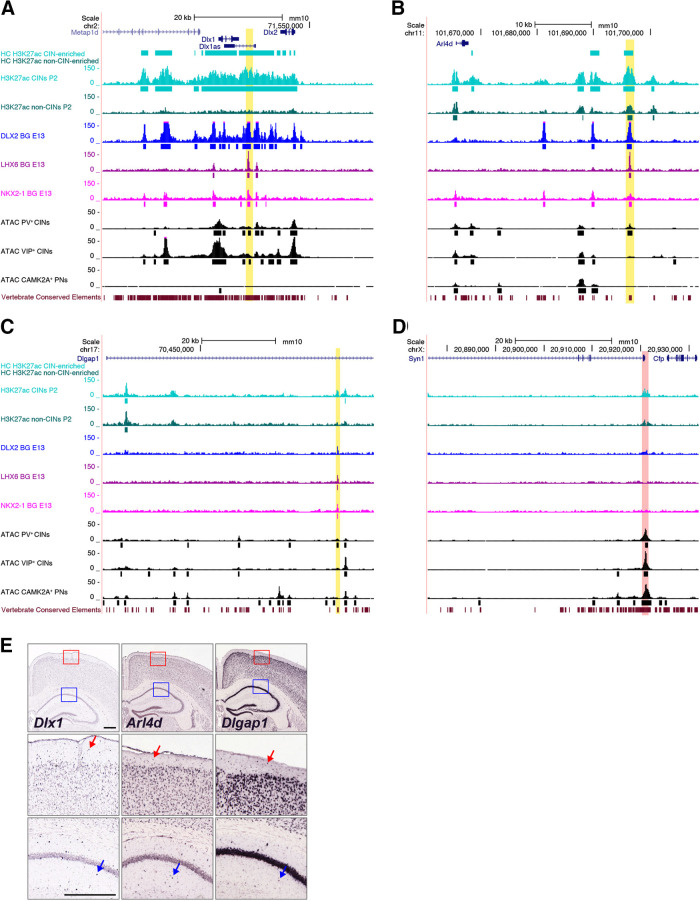
Integrated epigenetic signatures of candidate CIN pREs. A, The I12b RE region (yellow highlight) is highly enriched for H3K27ac in CINs compared with the non-CINs. It also has Dlx2, LHX6, and NKX2-1 TF binding peaks in E13.5 basal ganglia (BG) and shows enhanced accessibility by ATAC-seq in P30 PV+ and VIP+ CINs, but not in CAMK2A+ PNs. B, The Arl4d pRE (yellow highlight) is highly enriched for H3K27ac in CINs compared with non-CINs, has DLX2, LHX6, and NKX2-1 TF binding peaks and shows enhanced accessibility by ATAC-seq in P30 PV+ CINs but not VIP+ CINs or CAMK2A+ PNs. It also overlaps a vertebrate conserved element. C, The Dlgap1 intronic pRE (yellow highlight) shows greater enrichment of H3K27ac in CINs than in non-CINs and modest binding peaks for DLX2, LHX6, and NKX2-1. The Dlgap1 pRE overlaps an ATAC peak in P30 PV+ CINs, but not in VIP+ CINs or PNs, and a vertebrate conserved element. D, The Syn1 promoter region (red highlight) has comparable H3K27ac enrichment in CINs and non-CINs and is highly accessible in P30 PV+ CINs, VIP+ CINs and CAMK2A+ PNs. The highly conserved homologous human region drives AAV expression in many PNs and some CINs (see Fig. 5). HC called peaks are shown as solid bars under the corresponding bigwig track. Additional pREs are shown in Extended Data Figure 3-1. Coverage and called peaks separated by replicate for the Arl4d and Dlgap1 loci are shown in Extended Data Figure 3-2. E, In situ hybridization in adult cortex shows CIN-specific staining of Dlx1. Arl4d and Dlgap1 mRNA appear to be expressed in CINs [especially obvious in neocortical layer 1 (red arrows) and hippocampal stratum radiatum (blue arrows)] and many PNs. Images are taken from the Allen Brain Atlas (https://www.brain-map.org; Lein et al., 2007). Scale bars: 500 µm.